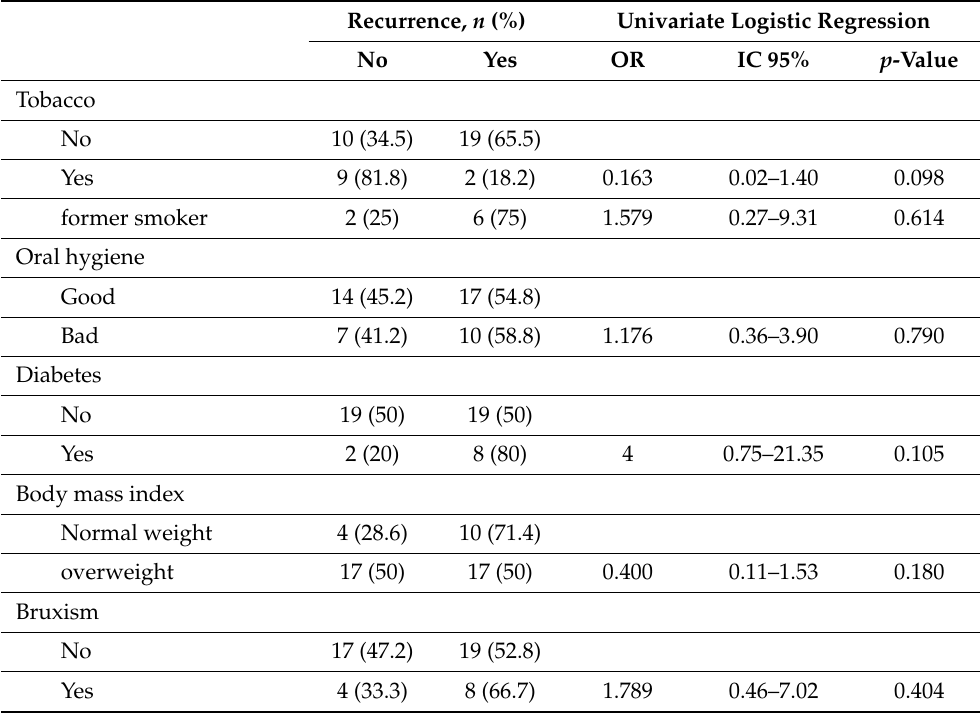
Table 2. Effect of variables related to patient habits on